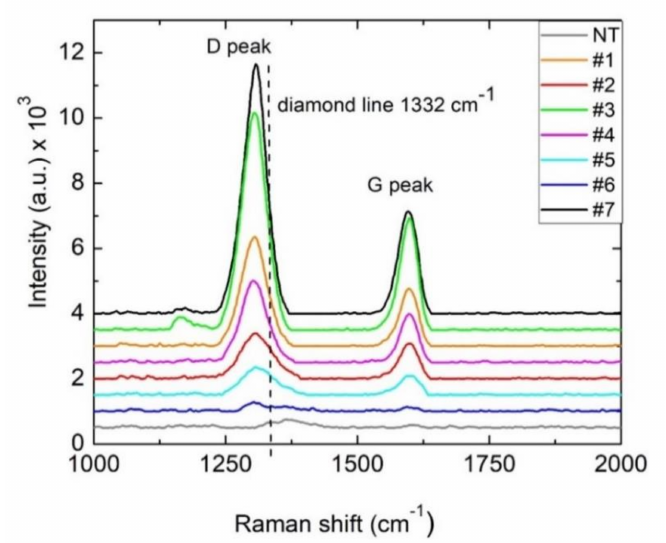
Figure 11. Raman spectra of the samples in original state (NT) and treated with plasma in different conditions. The position (1332 cm − 1 ) of the peak of diamond single crystal, indicated by the dashed vertical line, is displayed for